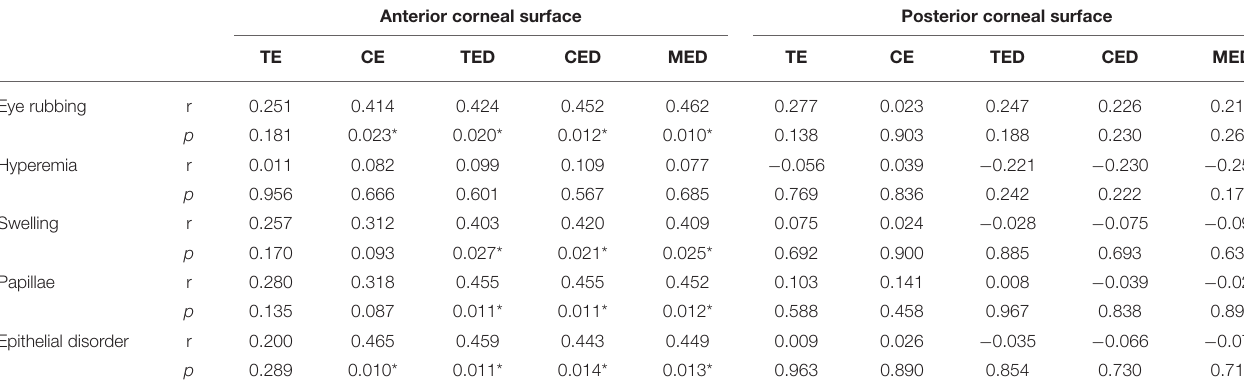
TABLE 5 | Correlation of altered corneal elevation parameters with eye rubbing frequency and ocular allergy sign severity in AC patients. Anterior corneal surface